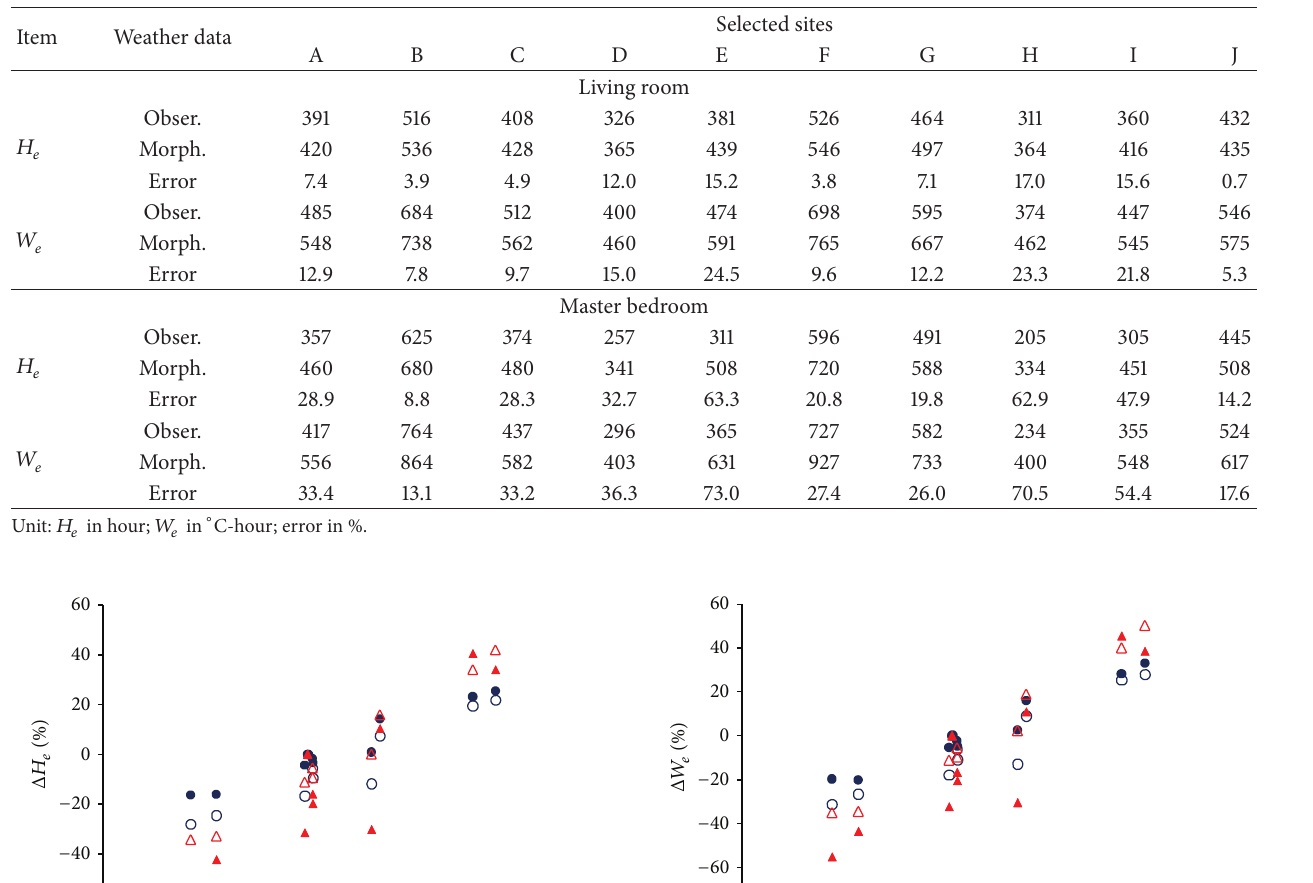
Table 6: 𝐻 𝑒 and 𝑊 𝑒 for naturally ventilated living room and bedroom at each site.